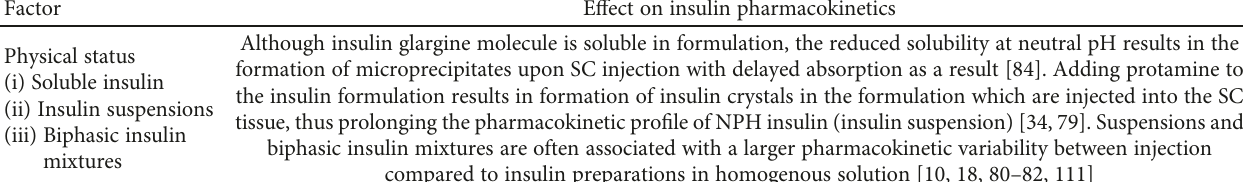
Table 2: Factors related to the insulin preparation and their e ff ect on insulin pharmacokinetics.